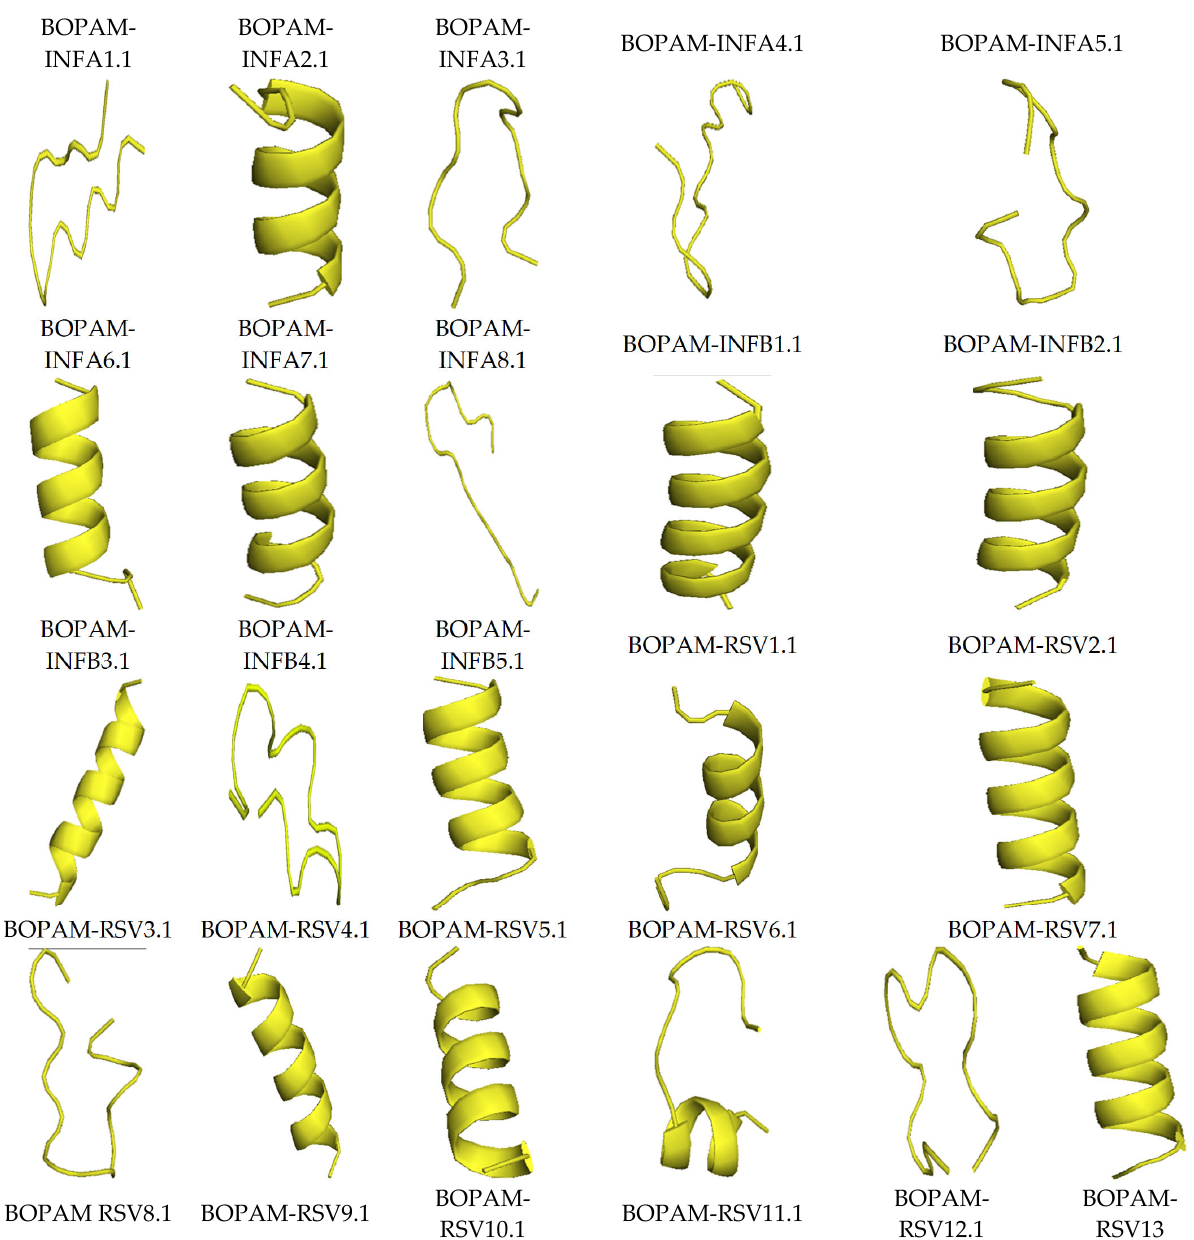
Figure 3. Structures of the derivative anti ‐ pneumonia AMPs using I ‐ TASSER. The AMPs showed different secondary structures including alpha ‐ helix, beta ‐ sheet, and extended conformations.